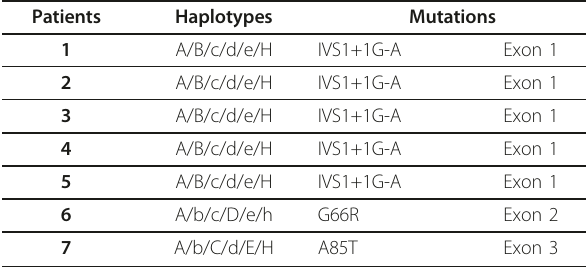
Table 3 Haplotypes and mutations detected within the studied patients